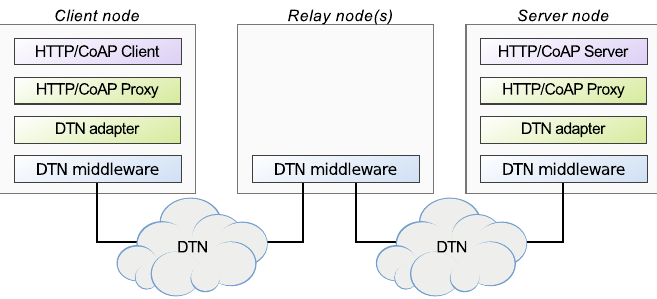
Figure 3. Overview of the implementation of the RESTful opportunistic computing middleware